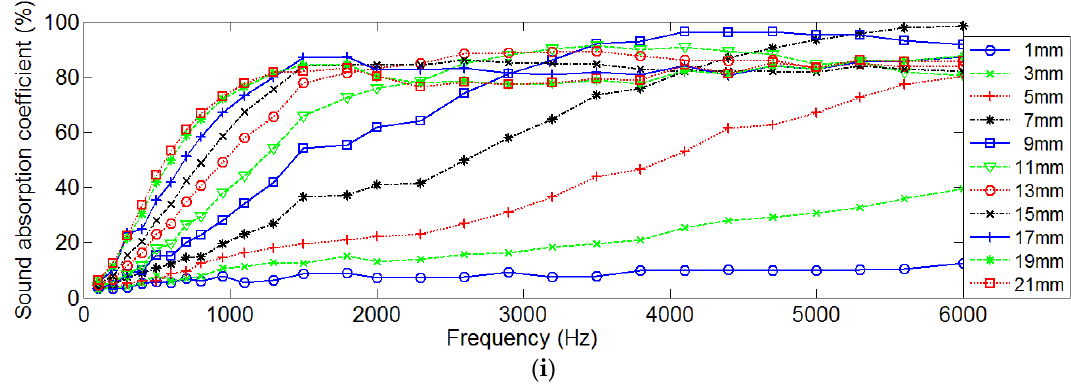
Figure 3. Evolutions of sound absorption coefficients of the compressed porous Ni – Fe samples. ( a ) With compression ratio of 0%; ( b ) With compression ratio of 10%; ( c ) With compression ratio of 20%; ( d ) With compression ratio of 30%; ( e ) With compression ratio of 40%; ( f ) With compression ratio of 50%; ( g ) With compression ratio of 60%; ( h ) With compression ratio of 70%; ( i ) With compression ratio of 80%.